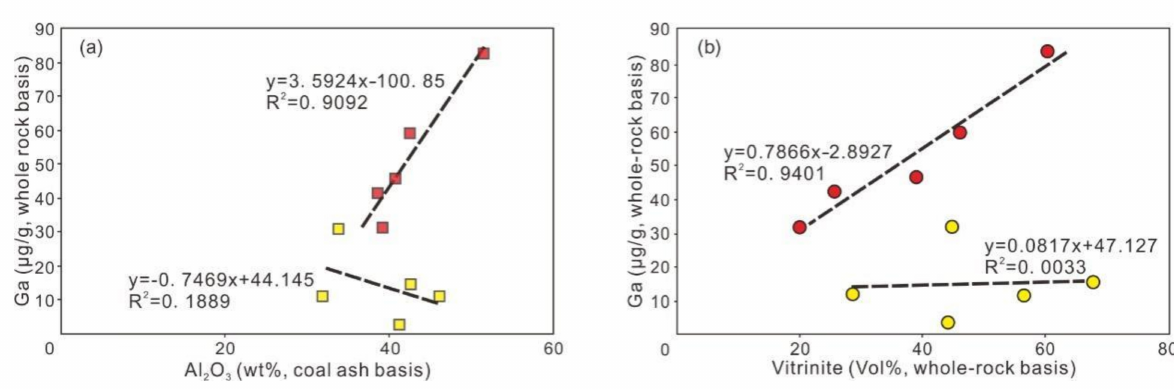
Figure 4. ( a ) Correlation between Ga and Al 2 O 3 . Red squares represented Ga-In-enriched horizons while yellow squares represented the rest of horizons. ( b ) Correlation between Ga and vitrinite. Red circles represented Ga-In-enriched horizons while yellow circles represented the rest of horizons.